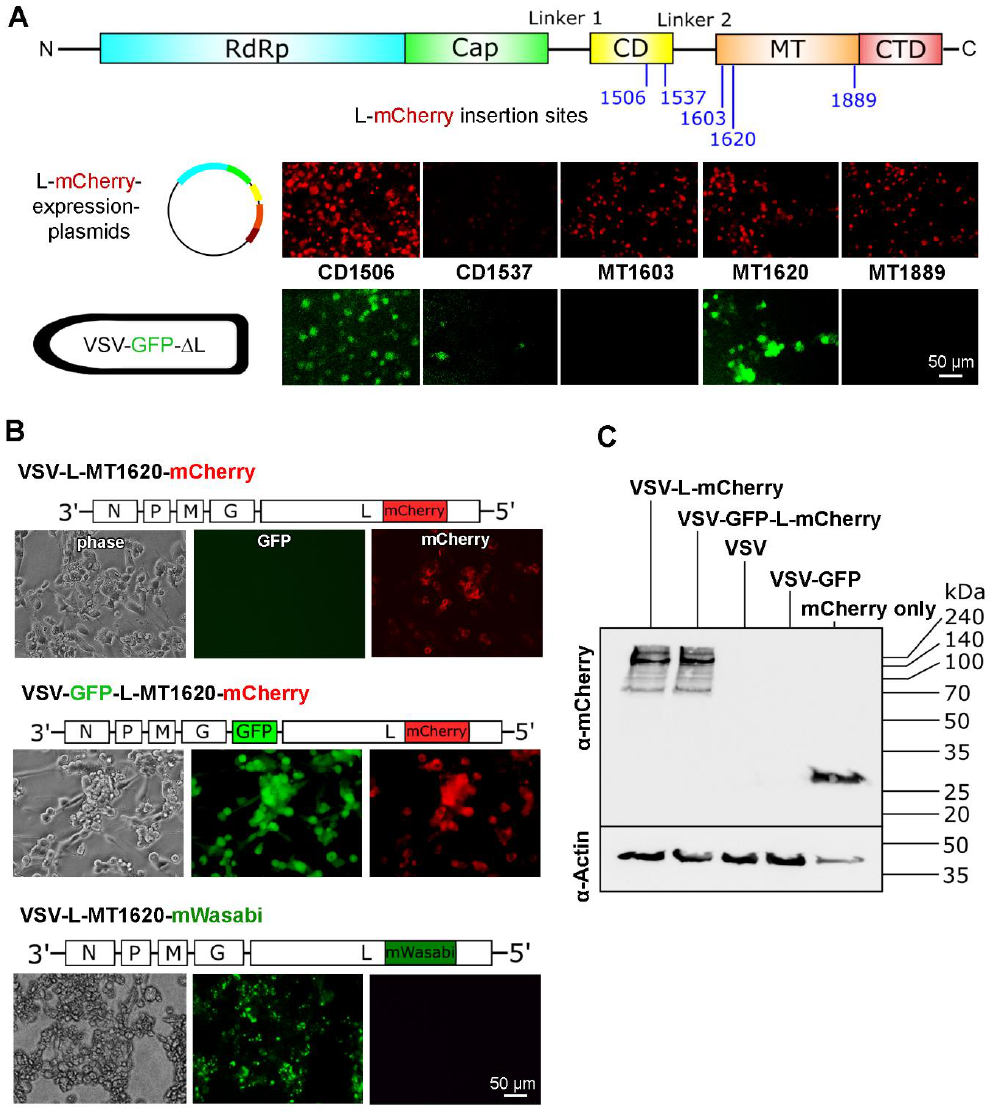
Figure 2. Insertion of mCherry at position MT1620 is compatible with VSV replication. ( A ) Top: VSV L-protein domain scheme with insertion sites. Middle: Images of 293T cells transfected with